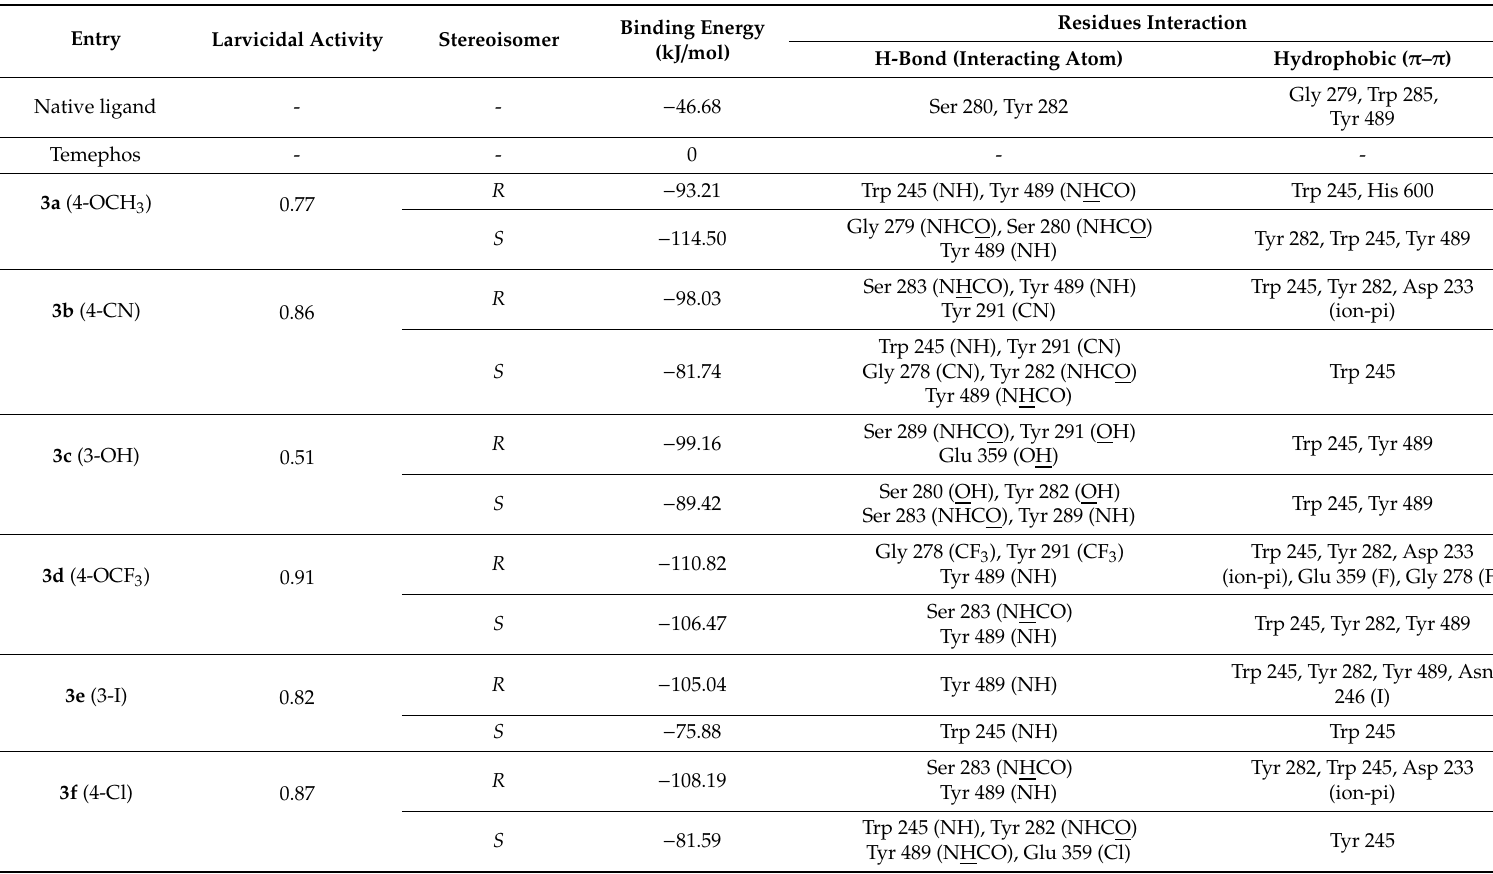
Table 6. Binding energy and residue interactions of 2,3-dihydroquinazolin-4(1 H )-one derivatives ( 3a – n) against G199S mutant acetylcholinesterase 1 (AChE1) (Protein Data Bank (PDB) code: